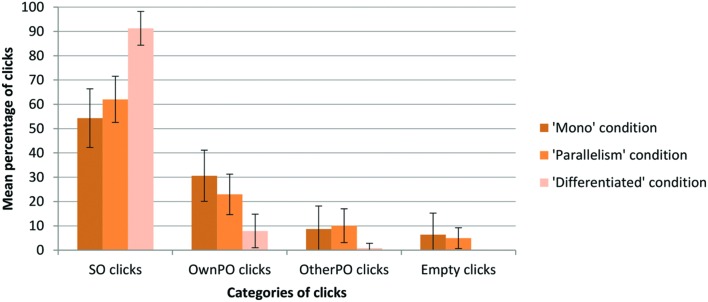
Mean percentages of clicks assigned to each category as a function of experimental conditionsxs.